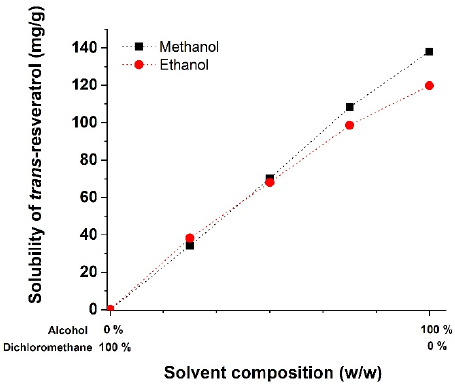
Figure 1. Solubility of trans ‐ resveratrol in different alcohol–dichloromethane mixtures at 25 °C.